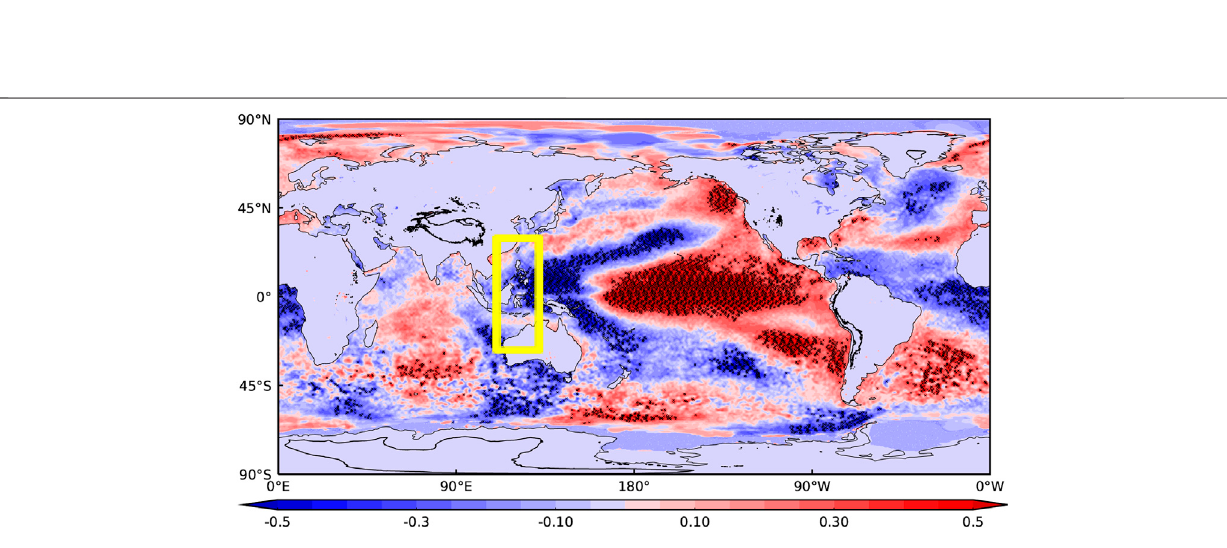
Frontiers in Earth Science |